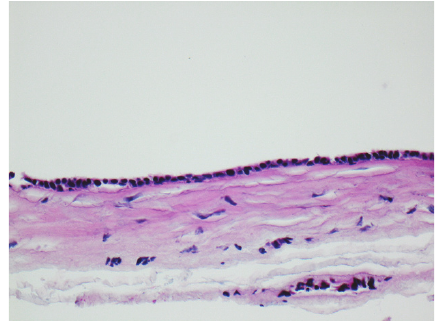
Figure 5: Close-up of a cyst wall demonstrates a cuboidal double- layered epithelium, consistent with an eccrine hidrocystoma. Hema- toxylin and eosin stain,